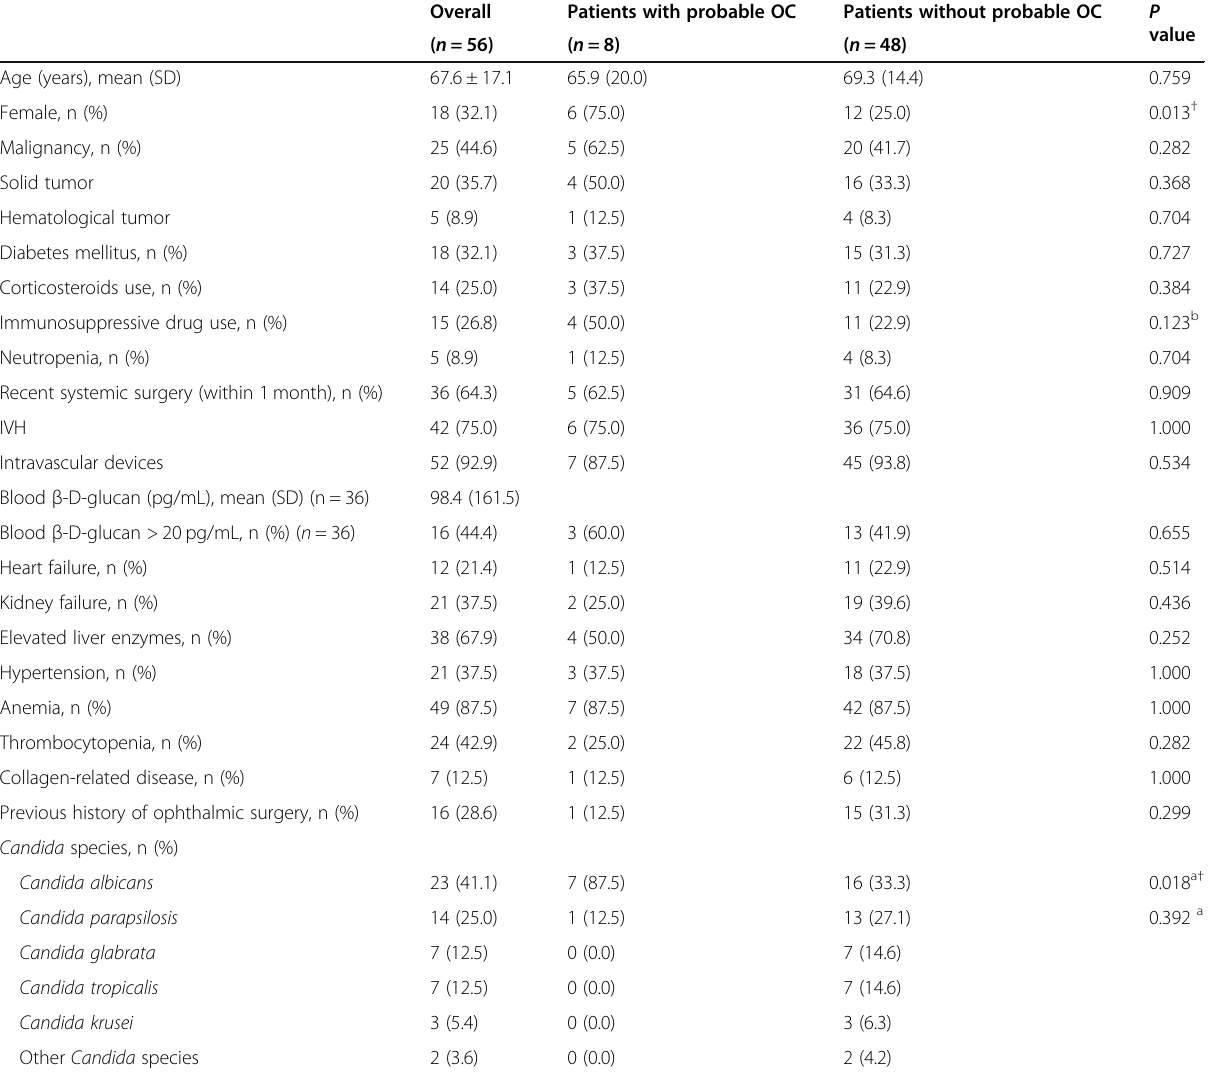
Table 1 Clinical characteristics of the patients with and without probable OC Overall Patients with probable OC Patients without probable